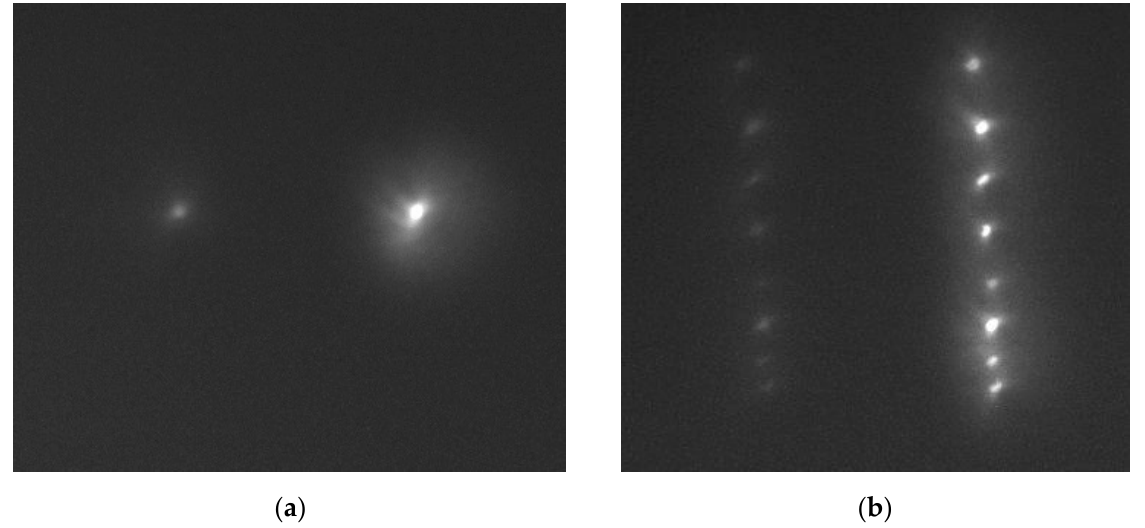
Figure 7. Matrix-displayed diffraction orders for wavelengths of 455 nm and 750 nm for ( a ) a single point source and ( b ) a